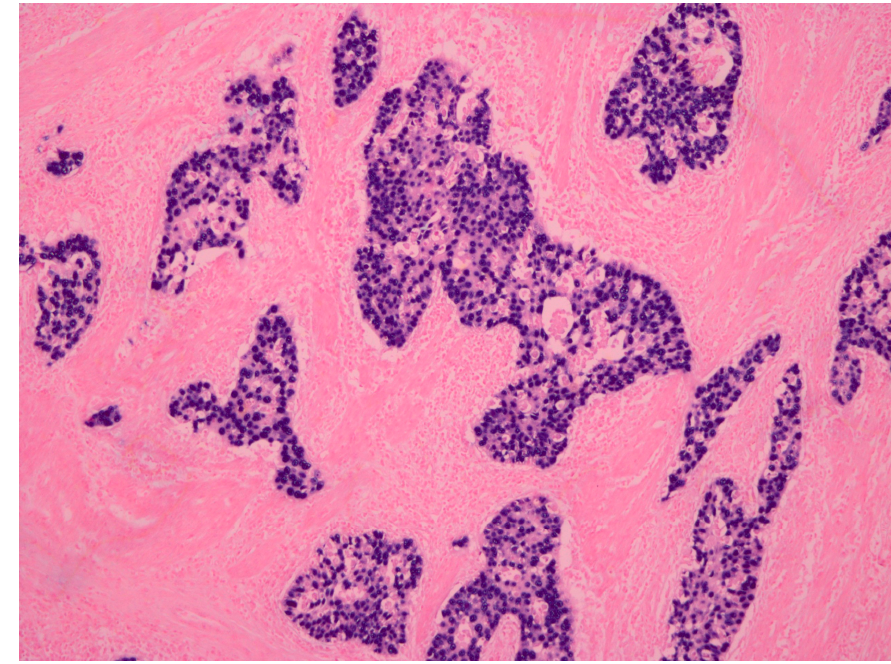
Figure 1. Representative case of Epstein-Barr virus (EBV)-associated gastric carcinoma. EBV-encoded small RNA 1 (EBER1) in situ hybridization (×100). Signals of EBER1 were detected in the nucleus of almost all cancer cells.